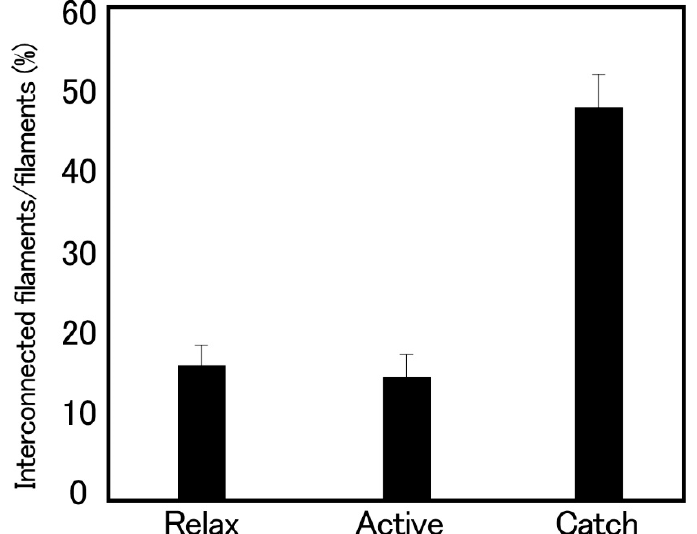
Figure 9. Histograms showing the proportion of the interconnected thick filaments, measured in the cross-sections of the ABRM fibers, quickly frozen in the relaxed, actively contracting and catch states. Bars indicate ±SD ( n = 8). (Takahashi et al. [36]).